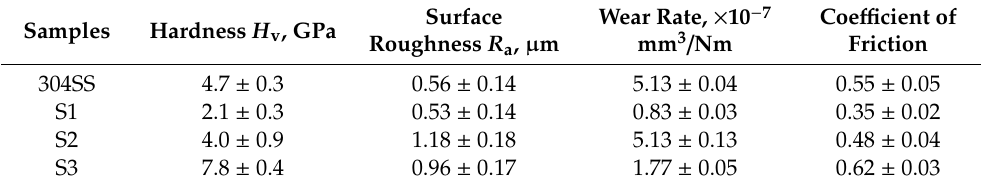
Figure 3. SEM images of surface and cross-sectional coating morphologies: ( a , b ) S1, ( c , d ) S2 and ( e , f ) S3. Table 3. Values of the coefficient of friction and the specific wear rate of different samples.